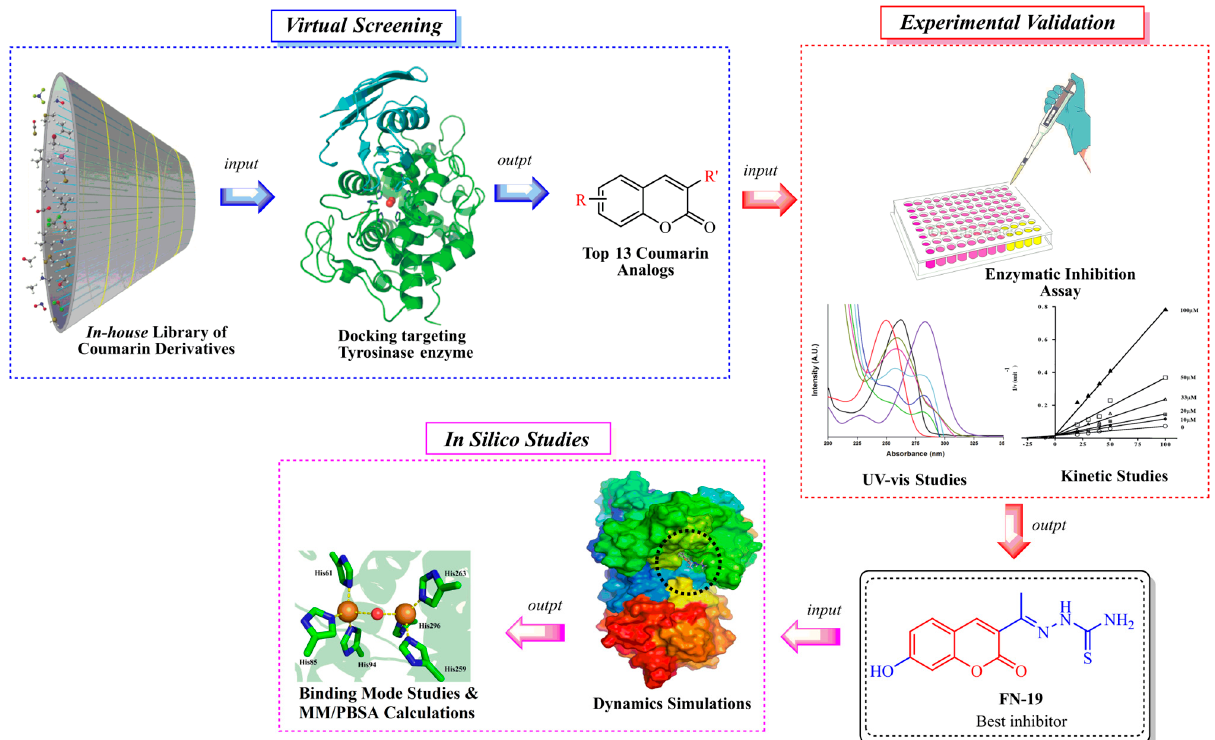
Figure 2. Workflow used in this study to identify tyrosinase inhibitors.